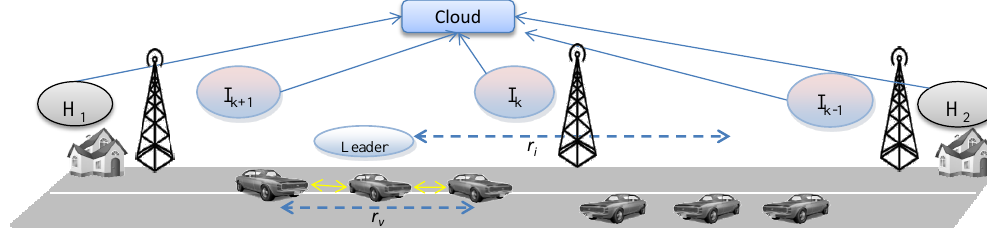
Figure 6. A scenario of the extended model.